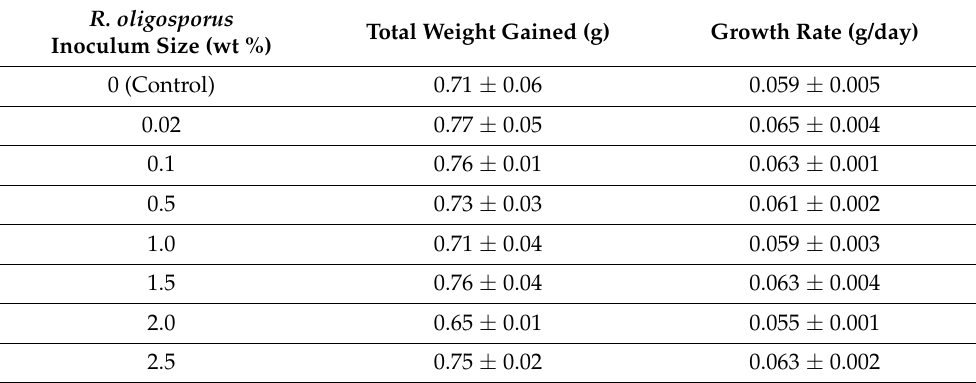
Table 1. Growth performances of black soldier fly larvae (BSFL) fed with in situ fermented coconut endosperm waste (CEW). Values are mean ± standard deviation ( n = 3).